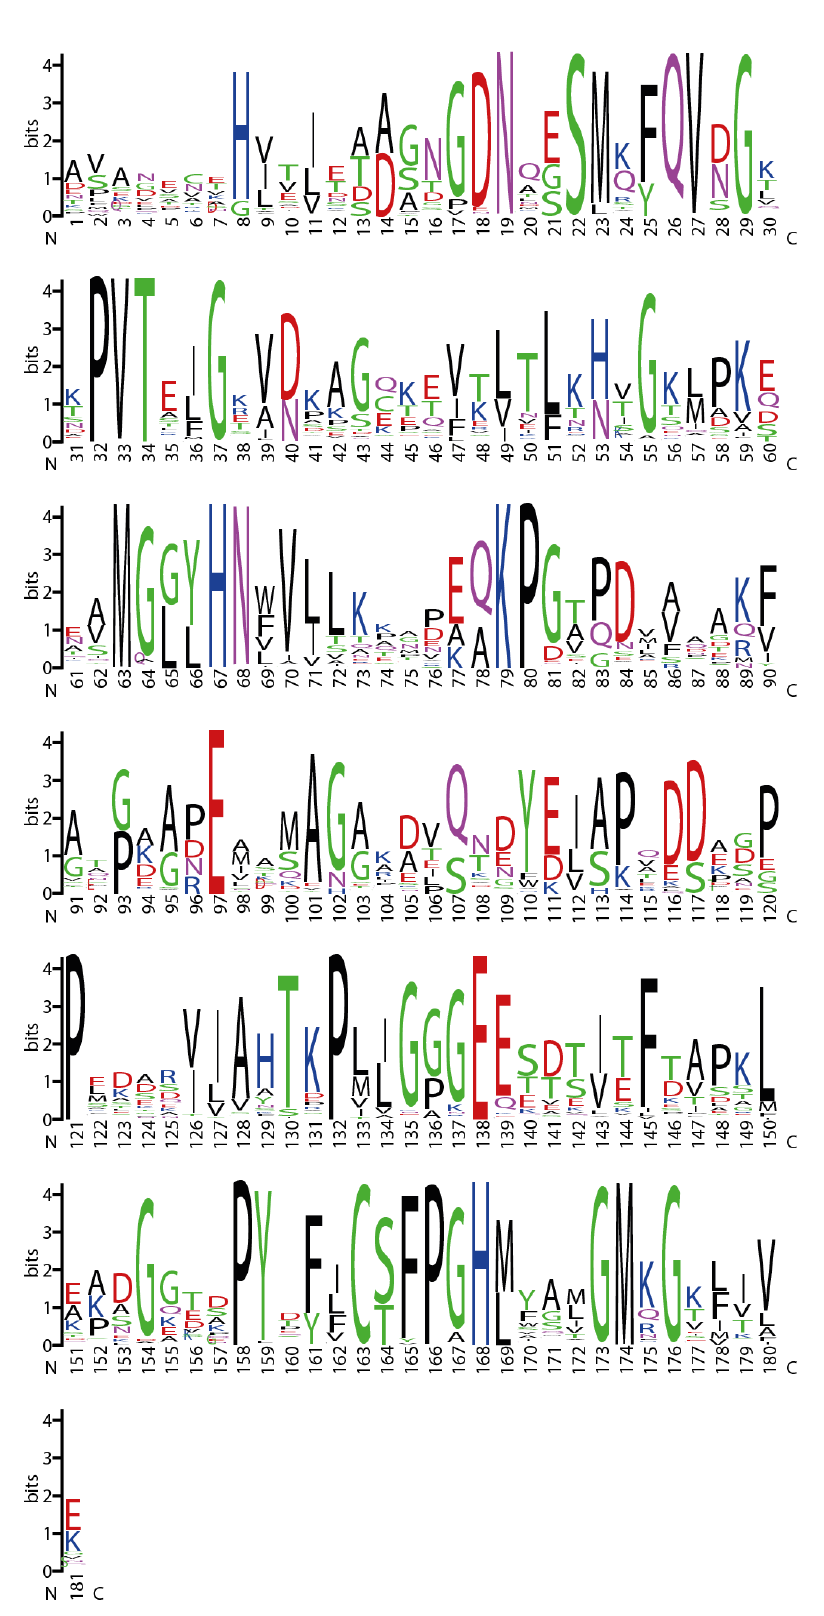
Figure 4. Logogram of the longest conserved domain shared by all the azurin-like sequences. Size of each letter corresponds to the frequency of the related amino acid in that position. Numbers on the X axis refers to the position of the retrieved alignment.